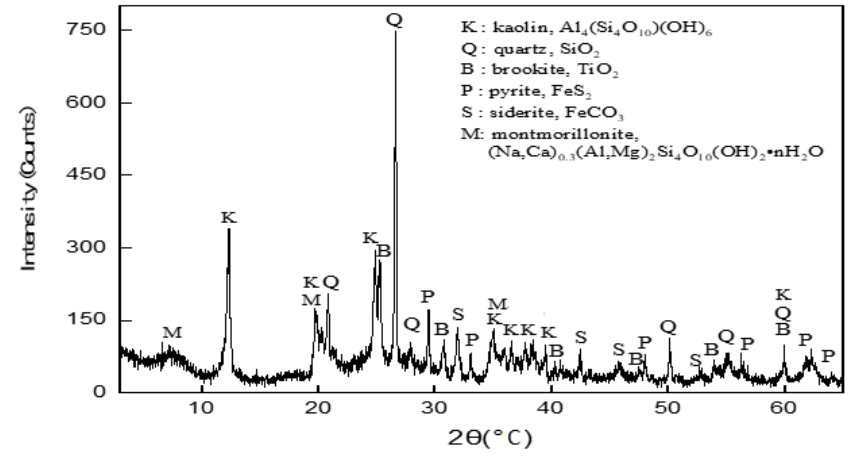
Figure 2. XRD spectrum of coal gangue powder.